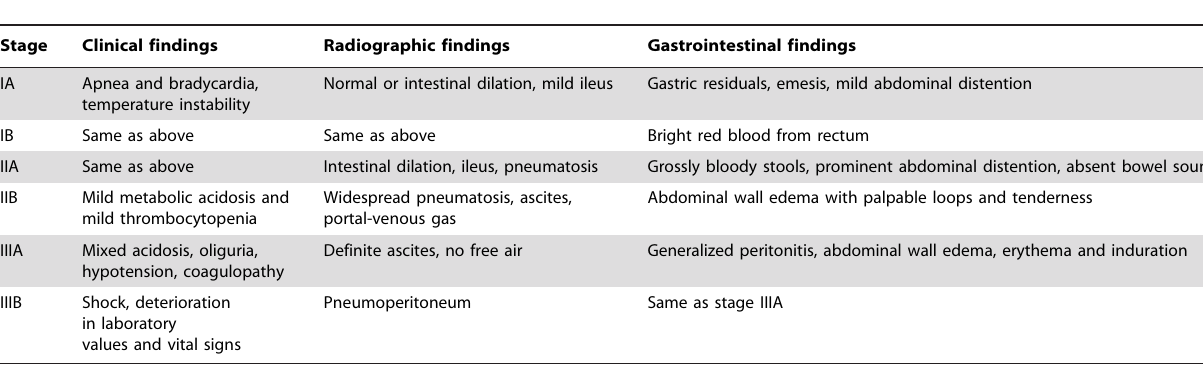
Table 1. Modified Bell’s criteria according to Walsh and